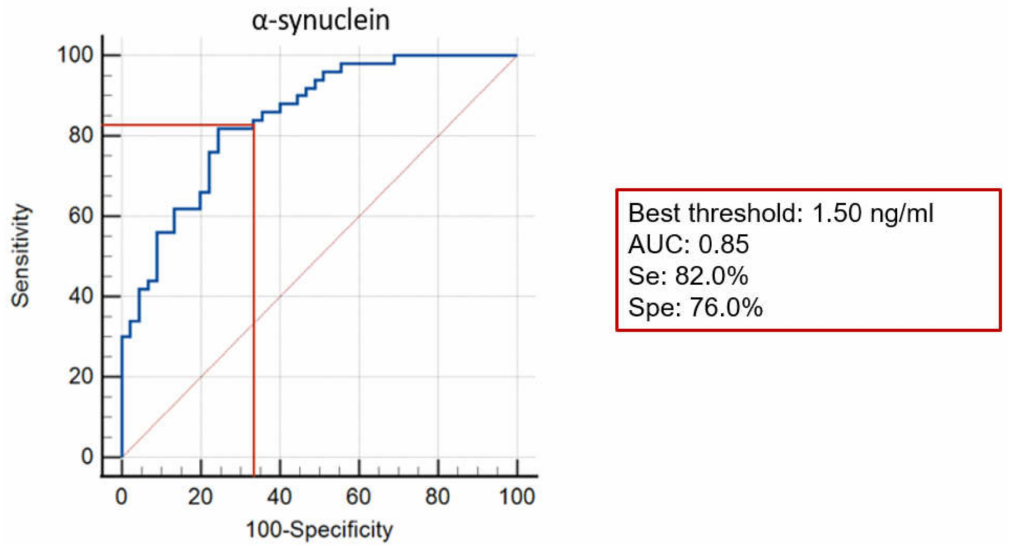
Figure 3. Receiver Operating Characteristic curve: CSF α -syn for discrimination between AD and DLB. AUC: Area Under the Curve, Se: Sensitivity, Spe: